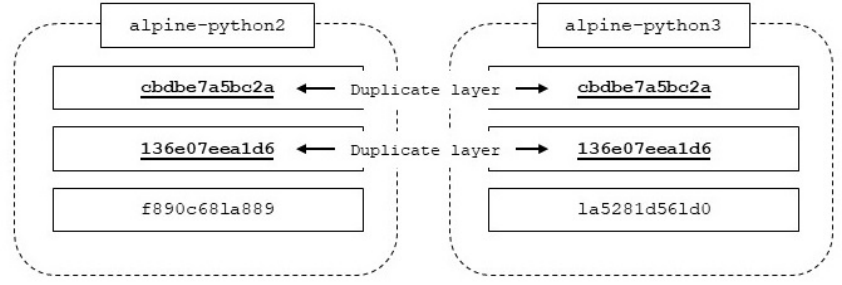
Figure 8. Image Repository Comparison